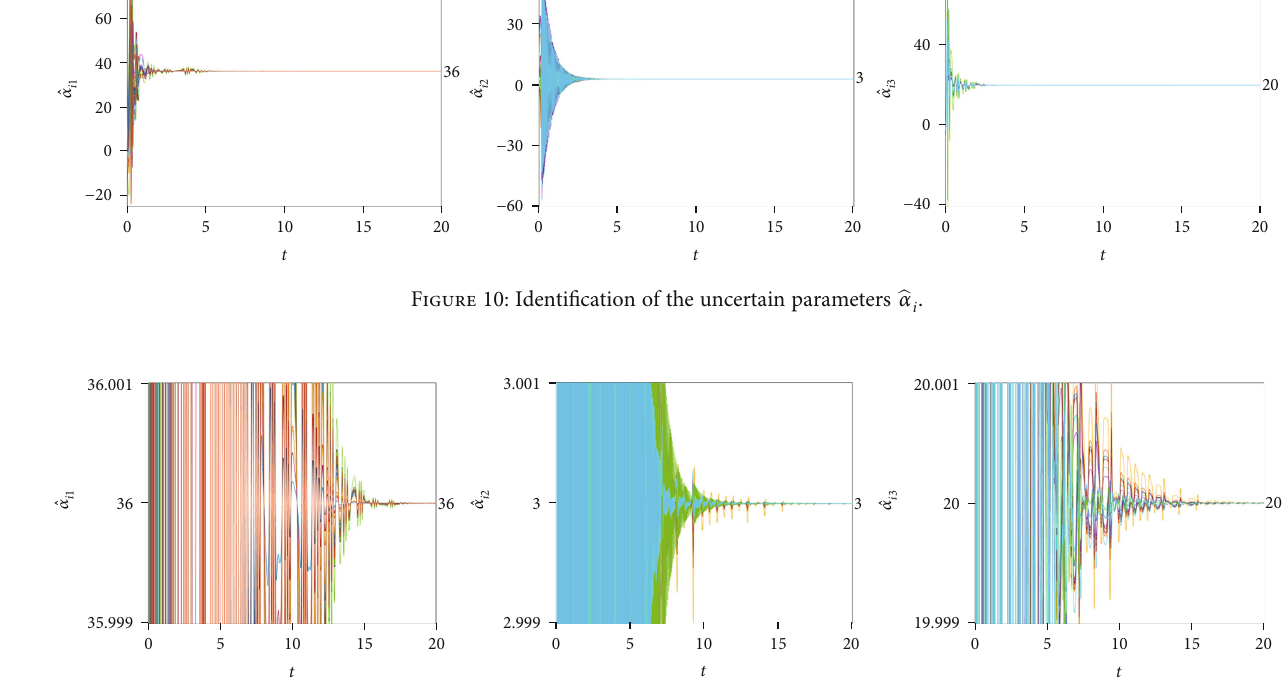
Figure 11: Partial ampli fi cation of the uncertain parameters b α